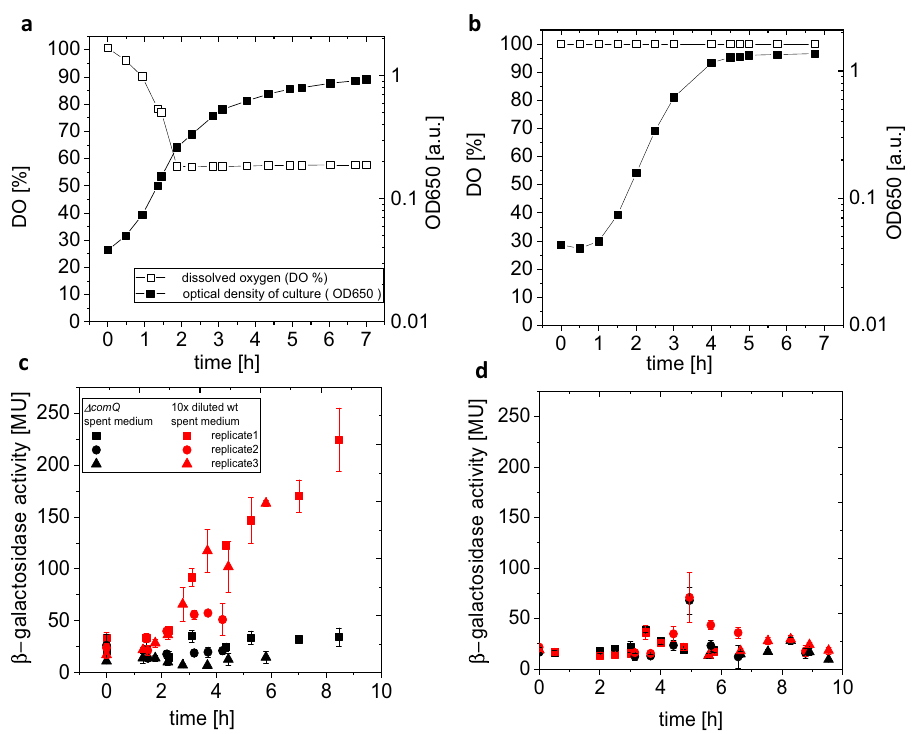
Fig. 3 In fl uence of O 2 on the presence of SM (ComX). a , c The strain PS-216 wt was grown in the fermenter batch system where oxygen supply was limited or b , d supplied to the saturation. a , b The growth was monitored by OD650 and oxygen saturation was followed by a polarizable electrode. c , d The samples of spent medium were periodically taken to test the presence of ComX via β -galactosidase activity of the ComX biosensor BD2876. The biosensor was incubated in the fresh CM medium supplemented with either spent medium of the Δ comQ strain (no ComX, negative control, black color), or supplemented with the wt strain spent medium 10 times diluted by spent medium of the Δ comQ strain (red color); the spent medium of the Δ comQ strain was obtained in the parallel batch system; n = 3 biologically independent experimental replicates are presented with error bars representing SD of 8 technical replicates. The comparison to positive control is given in Supplementary Fig.